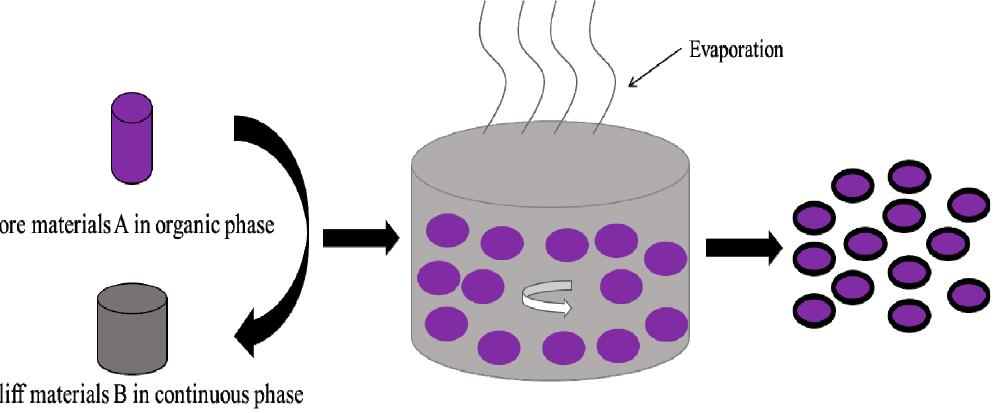
Figure 4. Microencapsulation with solvent evaporation.